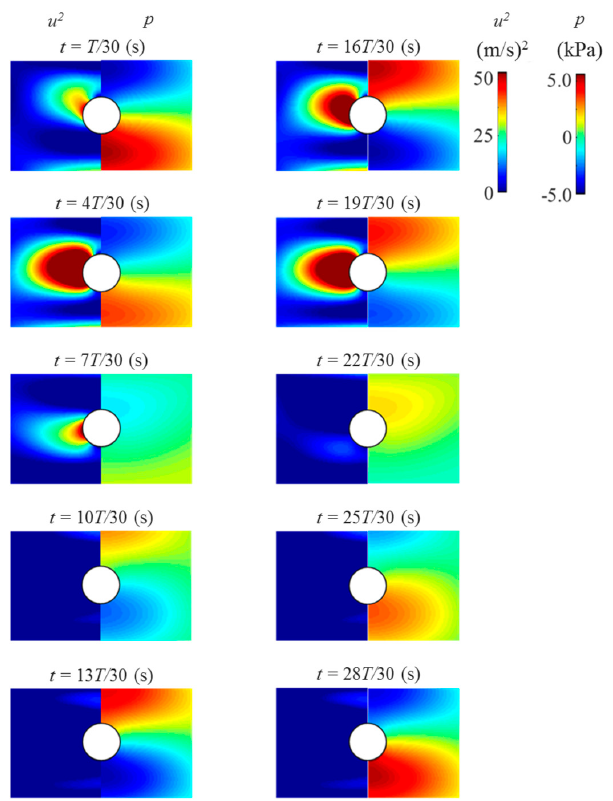
Figure 4. Time evolution of velocity ( left ) and pressure ( right ) fields around the levitated solid sphere using DPSM. The solid sphere was displaced 1 mm below the pressure node due to the gravitational effect to simulate the experimental result.